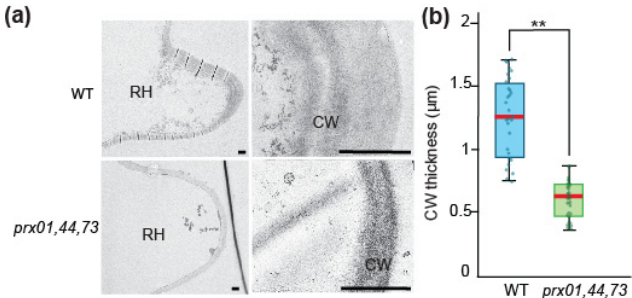
Figure 3. Effect of PRXs on cell wall thickness in root hair tips. ( a ) Transmission electron micrographs of developing root hair tips from Wt Col-0 and prx01,44,73 triple mutant. Representative overviews of young root hairs (RH) of each genotype and a detail of the cell wall at the root hair tip (CW) are shown. Scale bar = 1 mm. ( b ) Box and whisker plot showing variation in cell wall thickness measured at the root hair tip of the three genotypes. Graph shows quartiles, the middle line indicates the median and whiskers show the upper and lower fences. Dots indicate individual data points. (**) p < 0.001 determined by t -test.